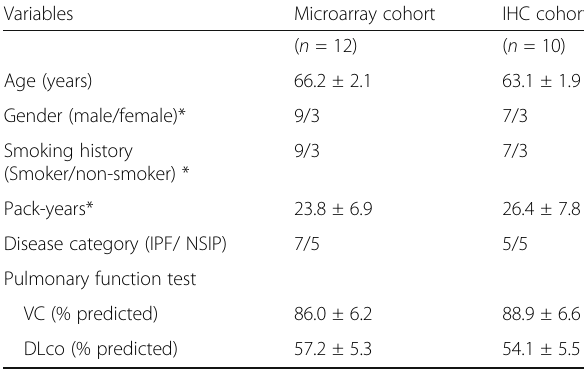
Table 1 Clinical characteristics of idiopathic interstitial pneumonia